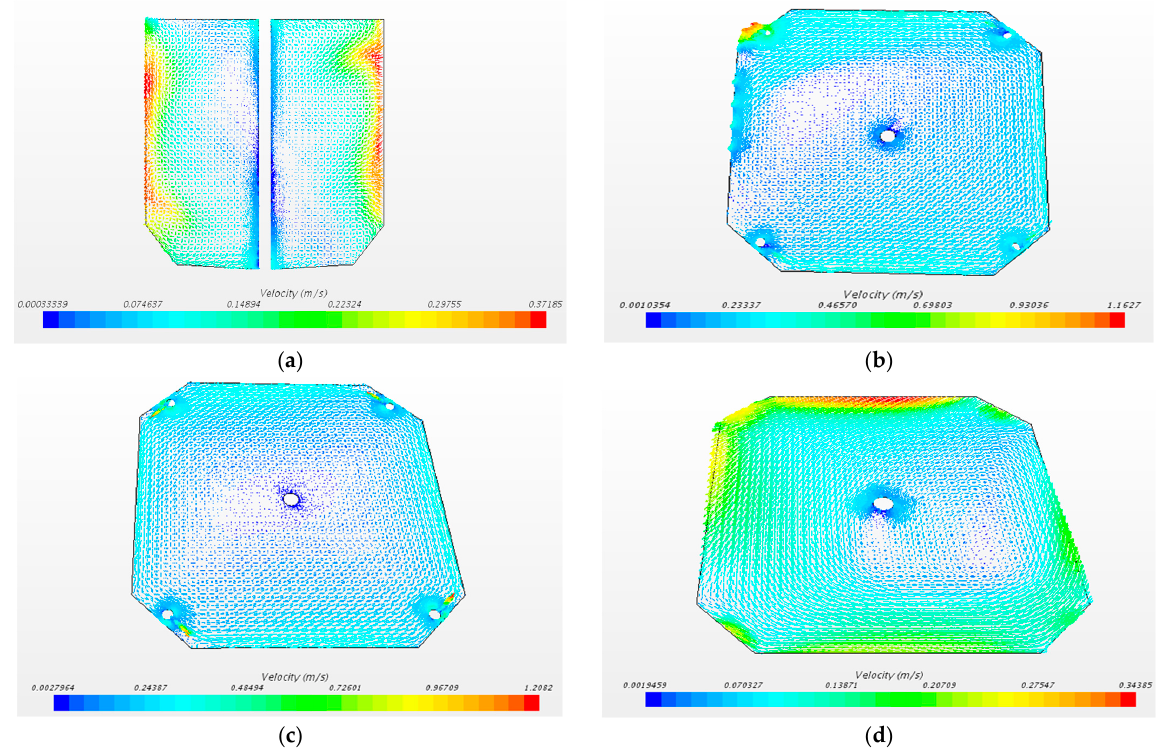
Figure 9. ( a ) middle longitudinal section, ( b ) H = 16.5 m cross section, ( c ) H = 8.5 m cross section, ( d ) H = 1.5 m cross